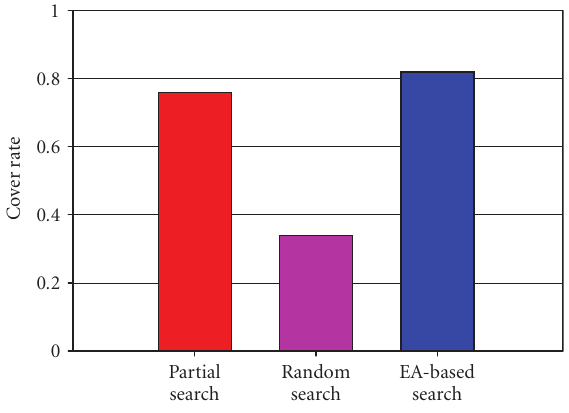
Figure 8: Comparison of search methods using cover rate. compared with the partial search, using only 10% of the execution